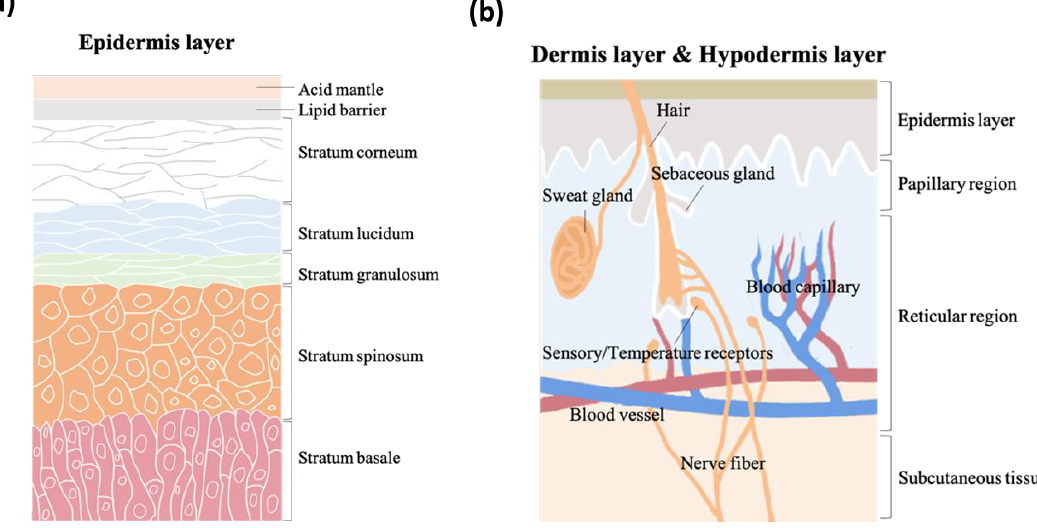
Figure 2. The schematic structure of ( a ) epidermis layer, ( b ) dermis layer, and hypodermis layer.